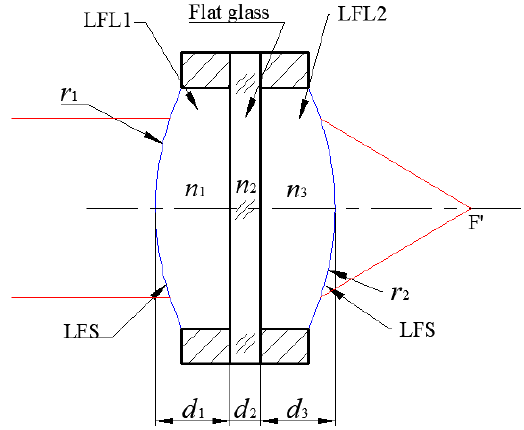
Figure 6. The structure of the UTL. r 1 and r 2 are the curvatures of two LFSs, respectively. n 1 is the index of refraction of LFL1, and n 3 is the index of refraction of LFL2. n 2 is the index of refraction of the